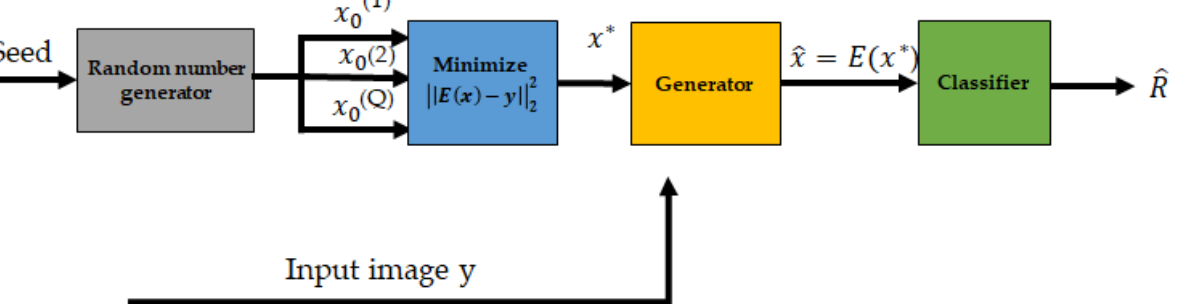
Figure 25. Overview of the adversary detector network. The experimental results indicated that the detector in Gong et al. [133] is sensitive to perturbation values in FGSM and BIM attacks and that a detector trained for FGSM attacks cannot detect other attacks. Gong et al. [133] and Grosse et al. [134] proposed